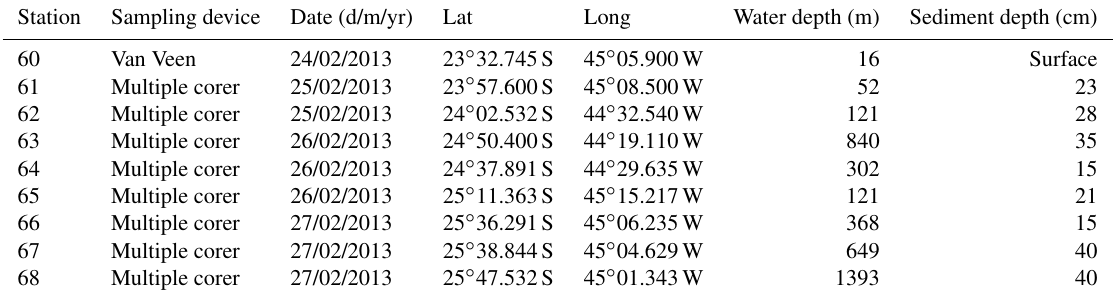
Table 1. Position of the samples analysed in this work. Station